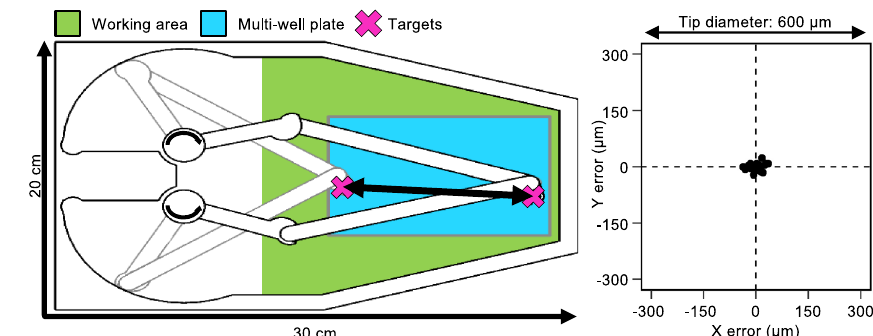
Fig. 2 PHIL reliably and accurately positions pipet tips in multi-well plates. a Pipets move to precise locations within full multi-well plate dimensions. Alternatively, this area can hold e.g. 1 × 10 cm dish, 4 × 3 cm dish, 4× ibidi channel slides, 96× PCR tubes, or any other vessel smaller than a multi-well plate. When moving between the centers of 2 wells across a 96-well plate (left), pipet locations varied by only ± 50 µ m in X and ±30 in Y (right, n = 57